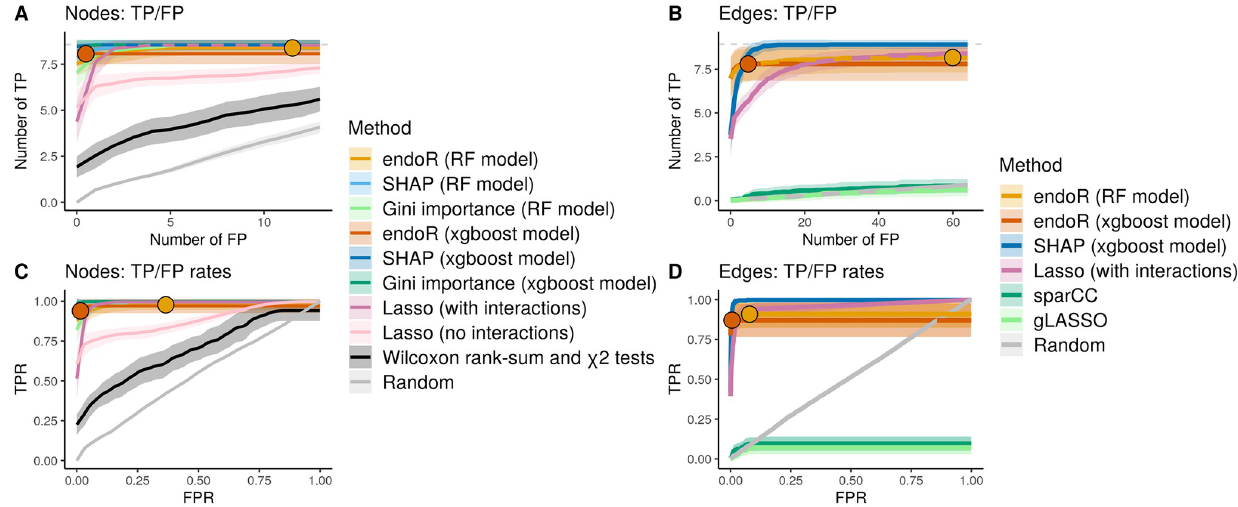
Fig 4. endoR is better or comparable to state-of-the-art methods at identifying true variables and pairs of variables predictive of artificial phenotypes. Average (line) and standard deviation (area) of identified true positive (TP) for a given number of false positive (FP). The average numbers of TP and FP in the endoR final decision ensemble are indicated with points. A, C: correspond to single variables and B, D: to pairs of variables across 50 replicates of artificial phenotypes. A, B: the truncated lines of absolute numbers of TP and FP are displayed, dashed grey lines denote the ground truth number of TP. C, D: the full curves of TP and FP rates are displayed. Lines are dashed when necessary due to overlaps. ‘Random’ signifies results expected with a randomization null model. A, C: All methods based on fitted predictive models almost perfectly ranked TP because of the feature selection step in model fitting. B, D: endoR better discriminated TP from FP edges than SHAP and lasso. Only endoR does not return all features and interactions, hence limiting the number of FPs in the final decision ensembles, although resulting in lower recall too.